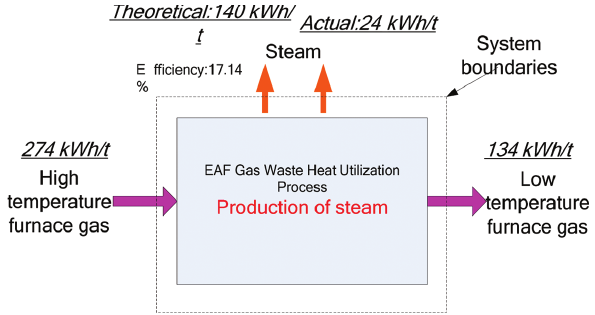
Figure 4: System boundaries of steam production for EAF gas waste heat utilization.